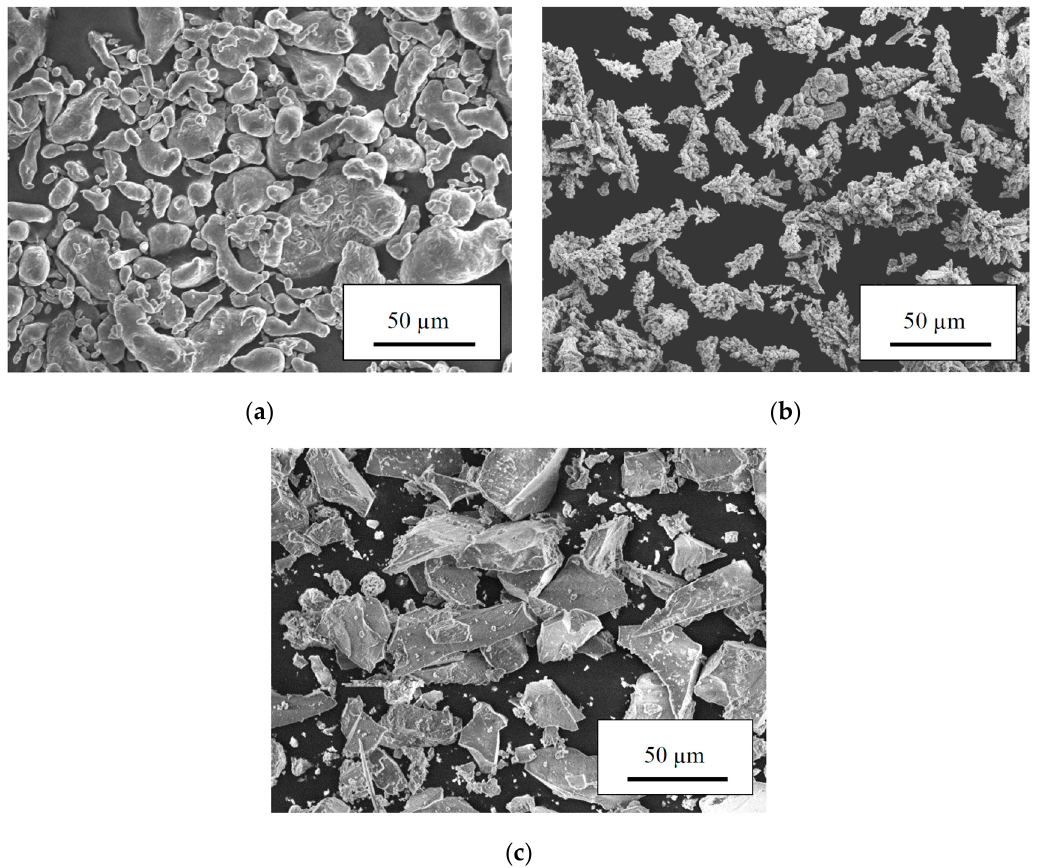
Figure 1. SEM images of powders used in the research: spheroidal aluminium ( a ), dendritic nickel ( b ) and irregular alumina ( c ).